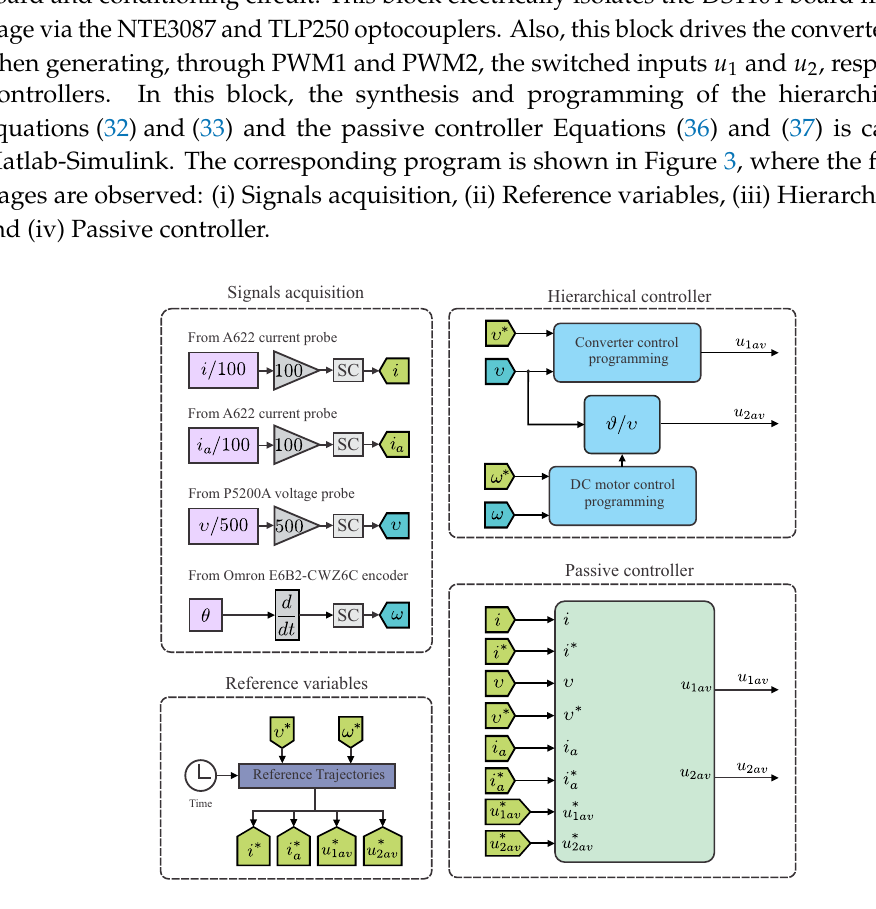
Figure 3. Controllers block implemented in